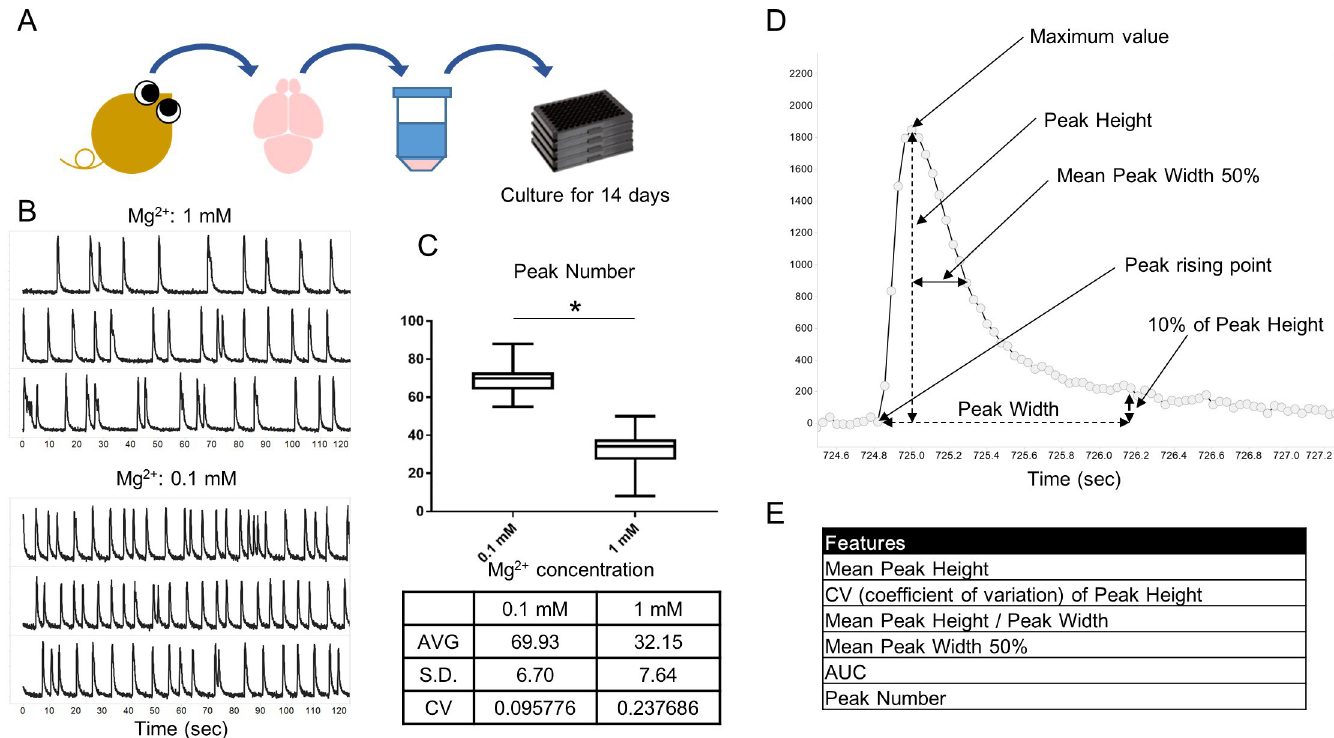
Fig 1. The schema for simultaneous measurement of calcium oscillations in 96-well plates and methods for extracting wave features. (A) Schematic of our method for measurement of calcium oscillations. Rat primary cortical neurons were harvested and cultured to DIV 14. Cultures were loaded with calcium indicator Cal-520 and measured in 60 wells (all except the perimeter wells on 96-well plates). (B) Representative calcium oscillations in 1 mM or 0.1 mM magnesium in Tyrode’s buffer. (C) Descriptive statistics and box plots of peak numbers in each condition. The horizontal line in each box represented the median location, the box represented the interquartile range, and the whiskers showed the minimal and maximal values. p * < 0.05 (unpaired t-test, n = 60 per condition). AVG, average; S.D., standard deviation; CV, coefficient of variation. (D) A representative calcium oscillation and definitions of wave features. Calcium oscillations were visualized and each feature extracted using Wave Finder in Spotfire. Features are defined as follows. Mean Peak Height is the difference between the maximum value of the peak and the height of the point at which the peak starts rising. Mean Peak Height / Peak Width was the ratio of the peak height to the peak width. Peak Width was the time from the point at which the peak starts rising to the time when the signal decreased to 10% of the peak height. Mean Peak Width 50% was the time from the maximum value to the time when the signal decreased to the half of this value. AUC was calculated using the trapezoidal rule. (E) The list of features extracted from calcium oscillations.